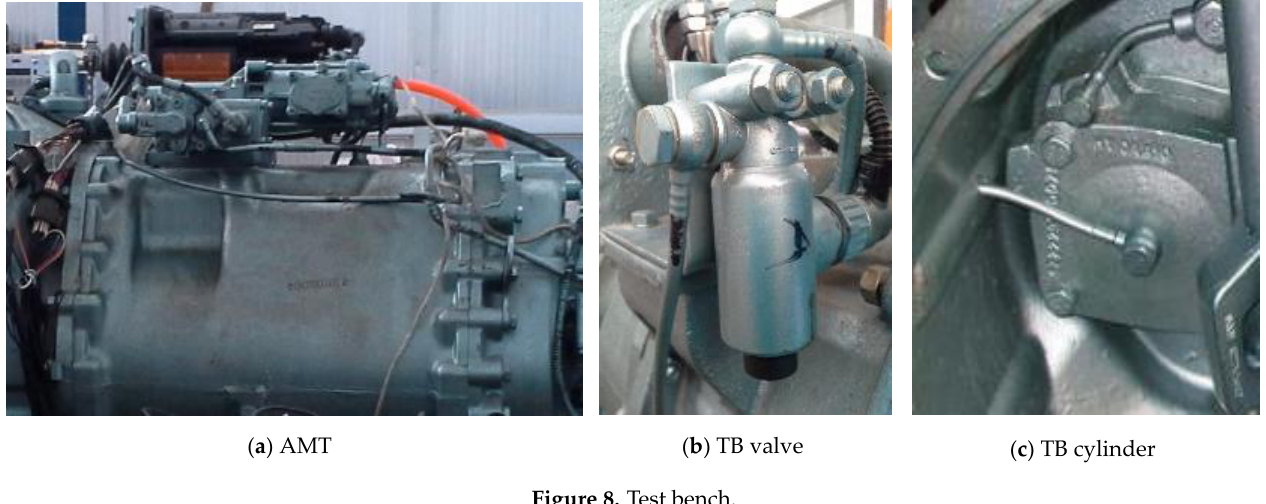
Figure 8. Test bench.